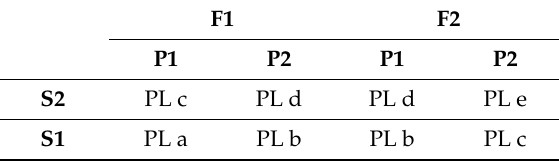
Table 7. Converted risk graph for high probability of occurrence of the hazardous event.